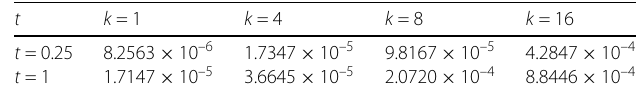
– I h u n (cid:7) 1, h with h = 1 h